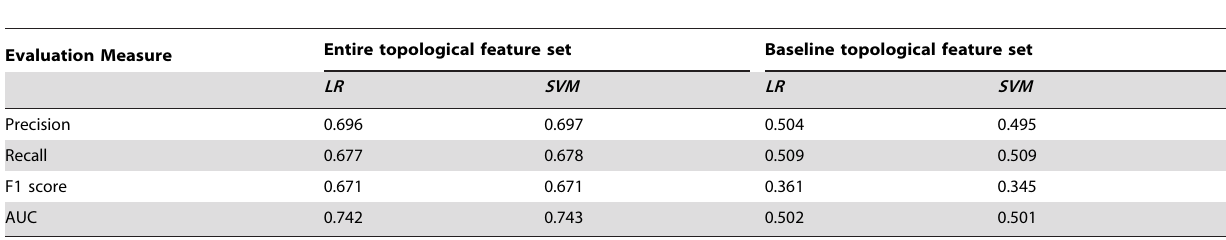
Table 3. Test results of LR and SVM model for entire topological feature set vs. baseline topological feature